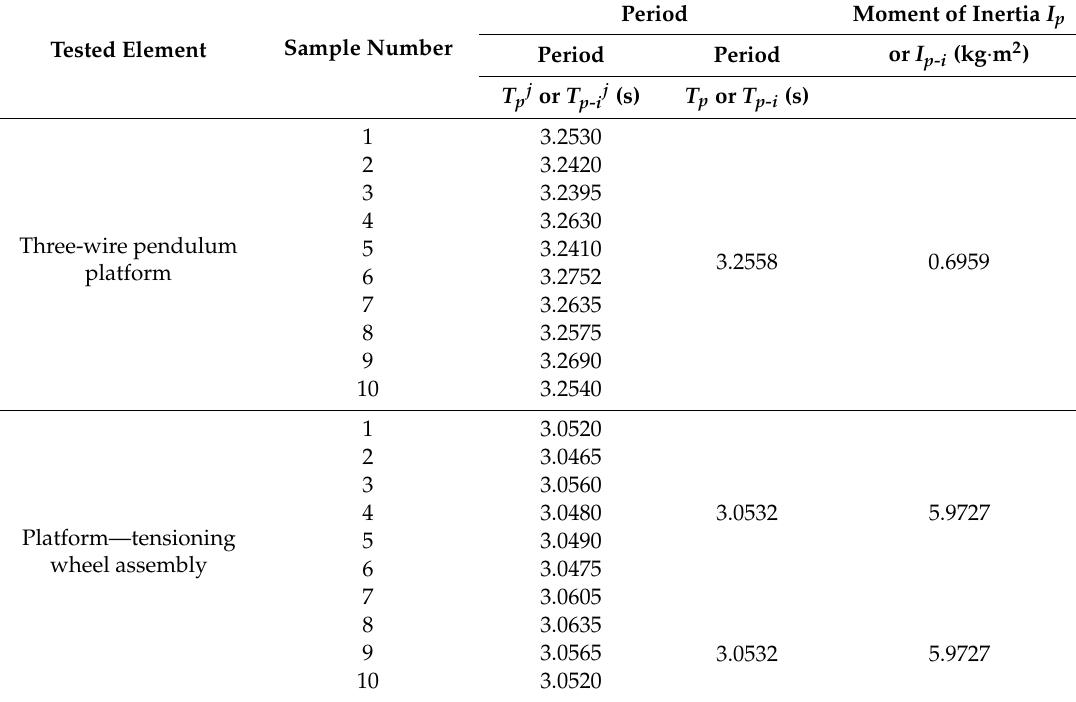
Table 6. Experimental data obtained with the three-wire pendulum